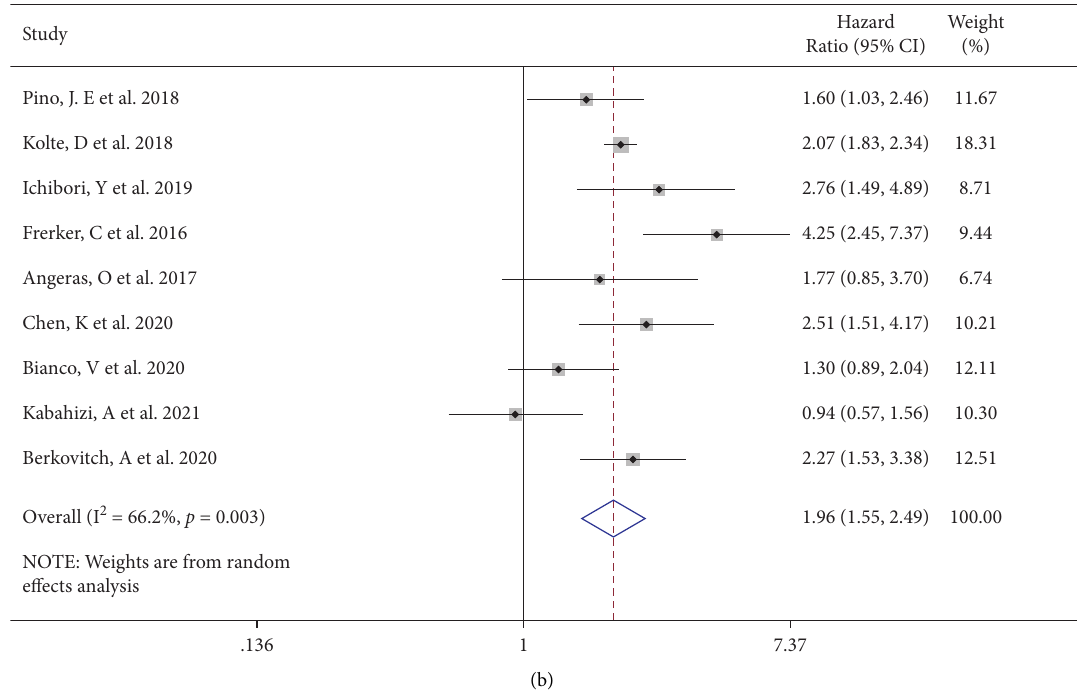
Figure 4: Forest plot showing a higher incidence of in-hospital (a) and 1-year (b) mortality of the emergent TAVI group. CI, confidence interval.